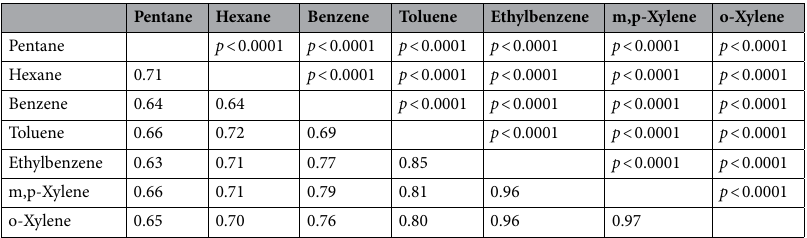
Pentane Hexane Benzene Toluene Ethylbenzene m,p-Xylene o-Xylene